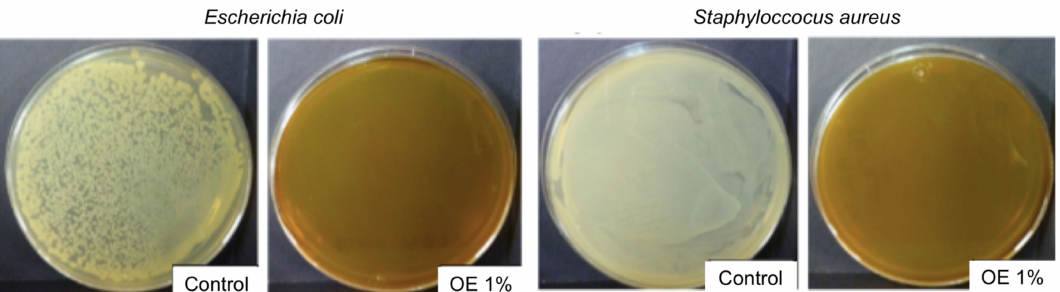
Figure 1. Antimicrobial activity of olive extract (OE) at 1 wt% observed by using the agar-plate di ff usion method.